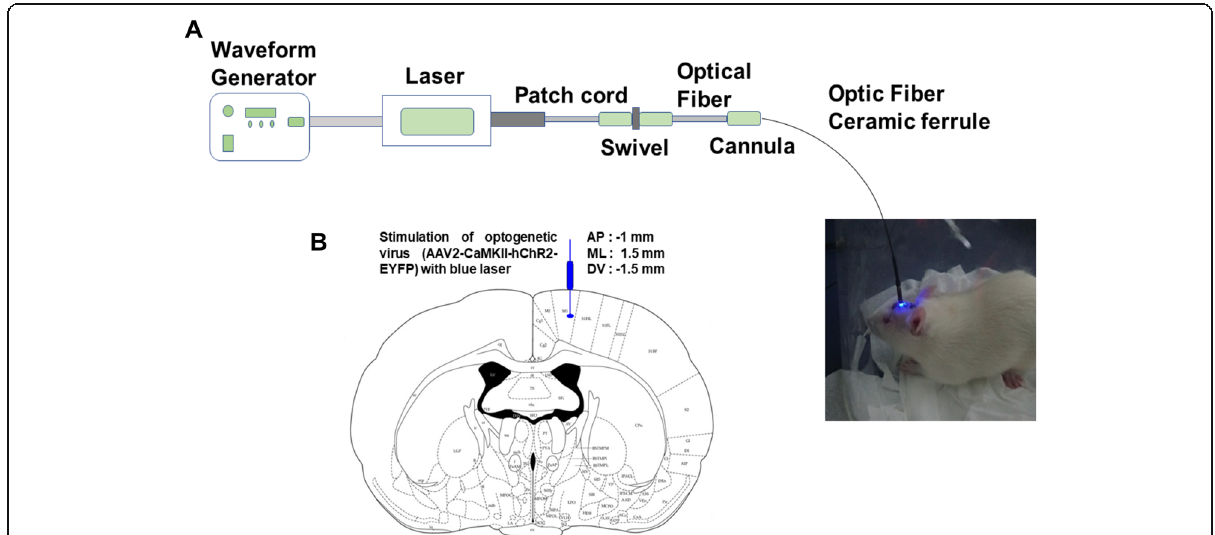
Fig. 2 Optogenetic stimulation procedure. a Complete setup of optic stimulation. b Optic fiber implantation. c Stimulation of primary motor cortex using a blue